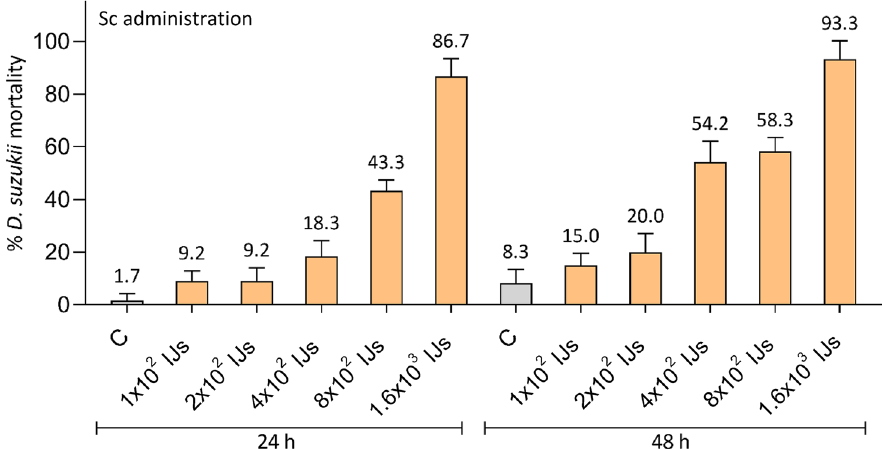
Figure 3. Effects of various amounts of S. carpocapsae (Sc) administered to L1 stage of D. suzukii larvae. Mortality rates were recorded at 24 and 48 h after administration. A concentration-dependent efficacy was observed, though relevant only with the highest number of Sc (1.6 × 10 3 IJs), at both 24 and 48 h. C control.